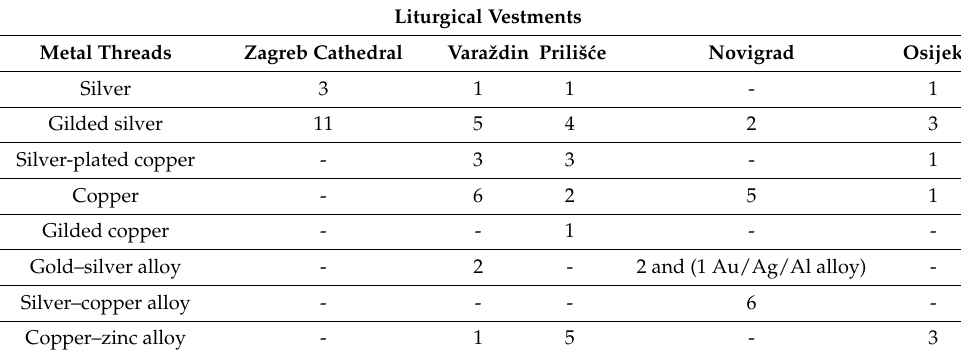
Table 3. Table of all metal thread samples from liturgical vestments.